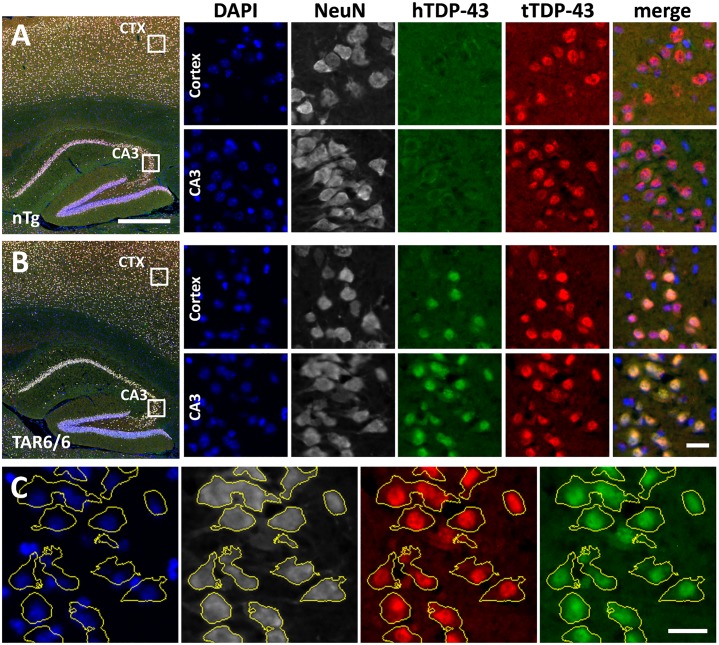
Immunofluorescent double-labeling of human and total TDP-43.Cortical and hippocampal tissue of three-months old ntg (A) and TAR6/6 (B) mice was labeled with antibodies against human TDP-43 (green) and total TDP-43 (red). Tissue was additionally labeled with NeuN antibody (white) and DAPI (blue) to visualize neuronal somata and nuclei, respectively. The merged images in the right column show human TDP-43, total TDP-43 and DAPI labeling. (C) The preferred nuclear localization of both human TDP-43 and total TDP-43 is obvious when the outlines of NeuN-positive somata are projected on the TDP-43 channels. Scale bars: Overview images = 500 μm; magnification images = 20 μm; (C) = 20 μm.